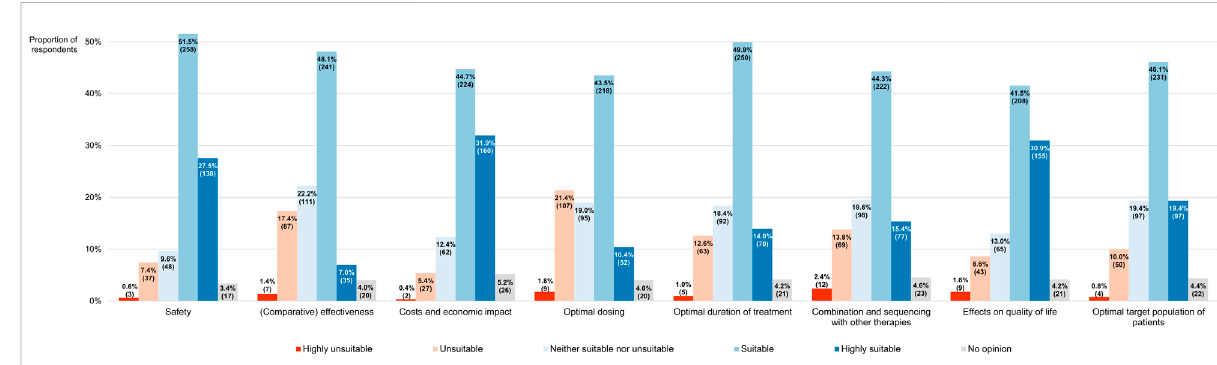
FIGURE 11 Participants ’ views on the suitability of real-world data for addressing different types of uncertainties relating to the adoption of new anticancer therapies into clinical practice. The percentages shown for each uncertainty may not add up to exactly 100% due to rounding. The numbers in brackets indicate the absolute number of respondents corresponding with each percentage.